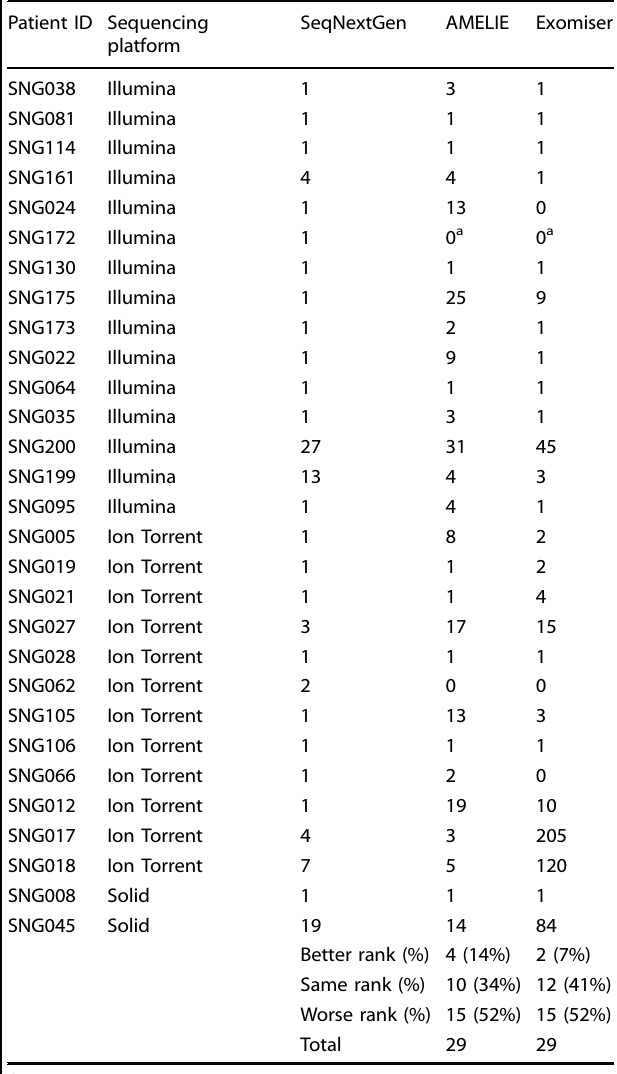
Table 3. Rankings obtained for 29 previously diagnosed cases using our SeqNextGen pipeline compared to Exomiser 18 and AMELIE 19